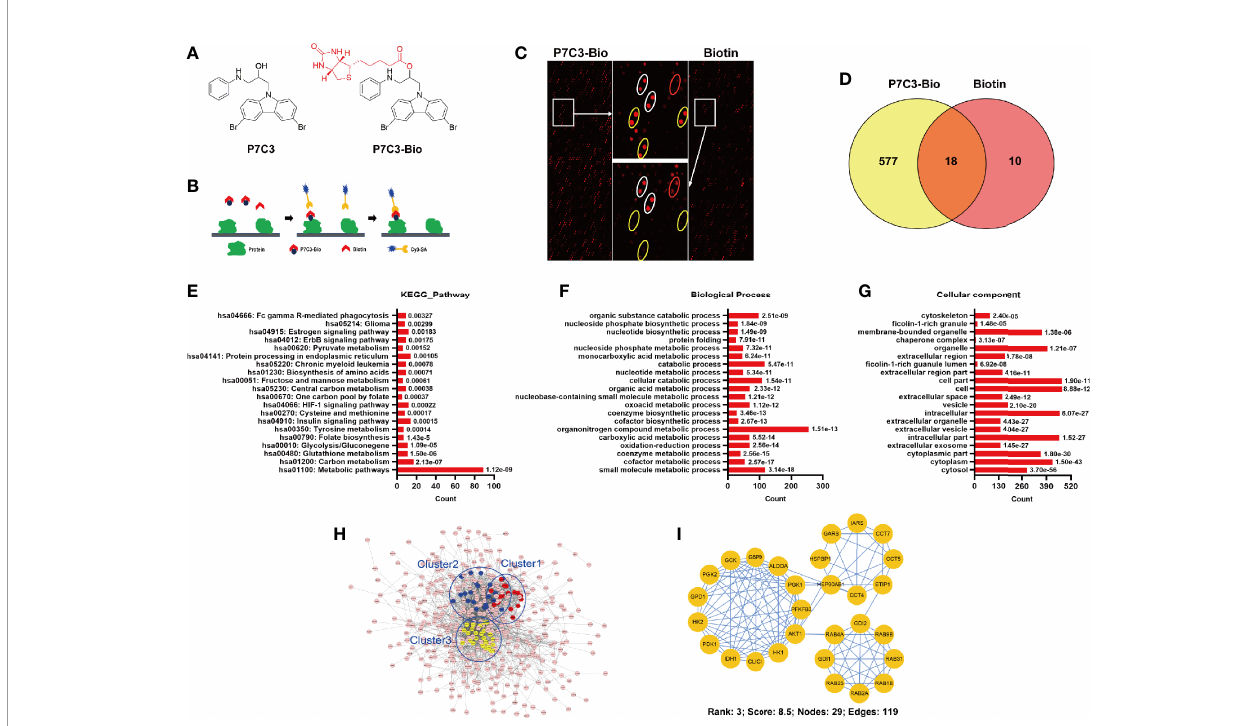
FIGURE 1 | Global pro fi le of P7C3-binding proteins on the human proteome microarrays. (A) Molecular structure of P7C3 and biotin-labeled (red) P7C3 (P7C3-Bio). (B) The schematic representation of identifying P7C3 target proteins using human proteome microarrays. (C) Representative images of protein array showing positive spots (inside the yellow circle) and negative spots (inside the white circle and red circle) on the partial area of microarrays. (D) Venn map of the positive spots for P7C3 target proteins and biotin target proteins. The number in the yellow area represents the number of P7C3 speci fi c target proteins. (E) Top 20 enriched pathways of P7C3 target proteins. (F) Top 20 enriched cellular components of P7C3 target proteins. (G) Top 20 enriched biological processes of P7C3 target proteins. (H) The complete interaction network of the P7C3 target proteins, the top 3 tightly connected clusters are color-coded. (I) The third-ranked cluster is glycolysis, with a score of